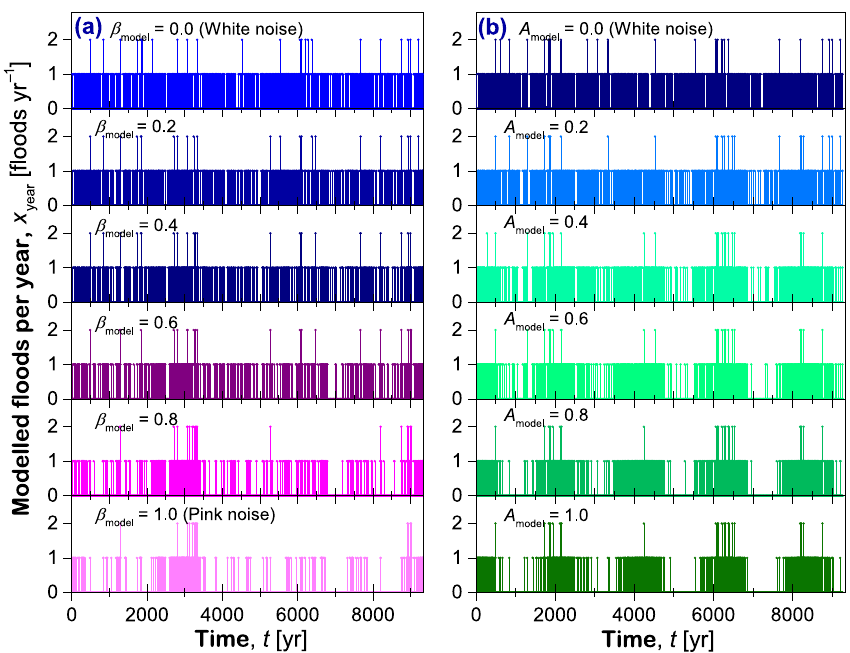
Figure 13. POT FGN + Period model realizations. Shown are (a) long-range persistent flood time series that are modelled with the proposed POT FGN + Period model (see Fig. 12) as peaks over thresholds (POTs) of a fractional Gaussian noise (illustrated in Fig. 5) with different persistence strengths β model = 0 . 0, 0.2, 0.4, 0.6, 1.0 and no superimposed periodic component ( A model = 0 . 0), and (b) flood time series x year with a long-term periodic cyclicity which are modelled as POTs of a Gaussian white noise ( β model = 0.0) superimposed with a sine wave ( T = 2030 years) with different sine wave amplitudes A model = 0 . 0, 0.2, 0.4, 0.6, 1.0.